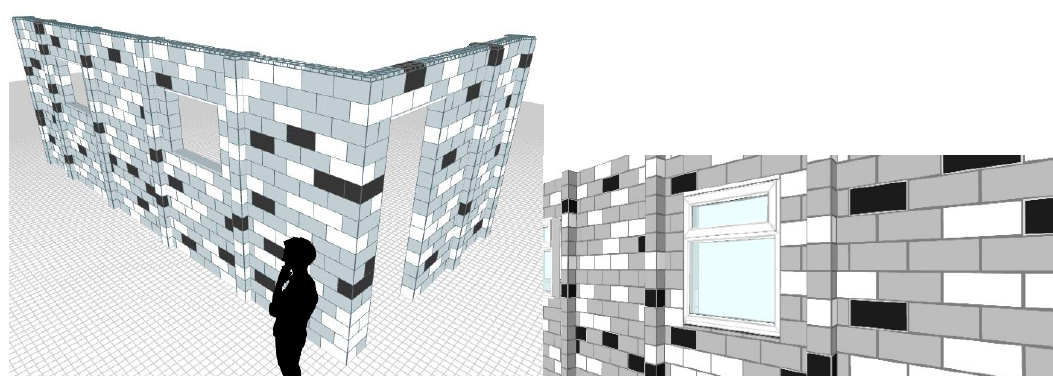
Figure 3. Desgin documentation of the modular building block solution designed and procured from Everblocks. This has facilitated the development of the living lab.